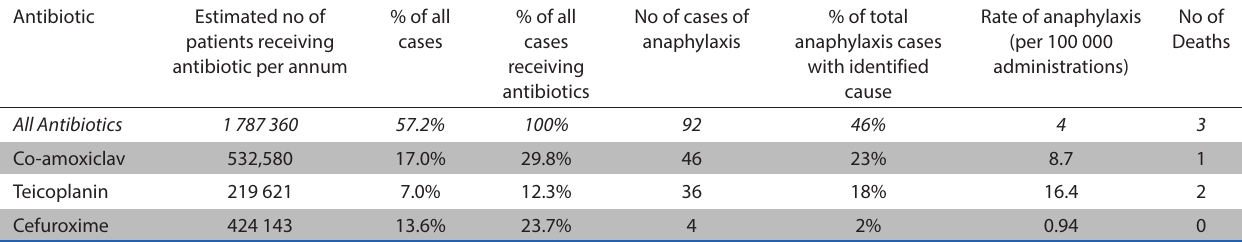
Table 2: Summary of NAP6 results regarding Antibiotics 2,22,26